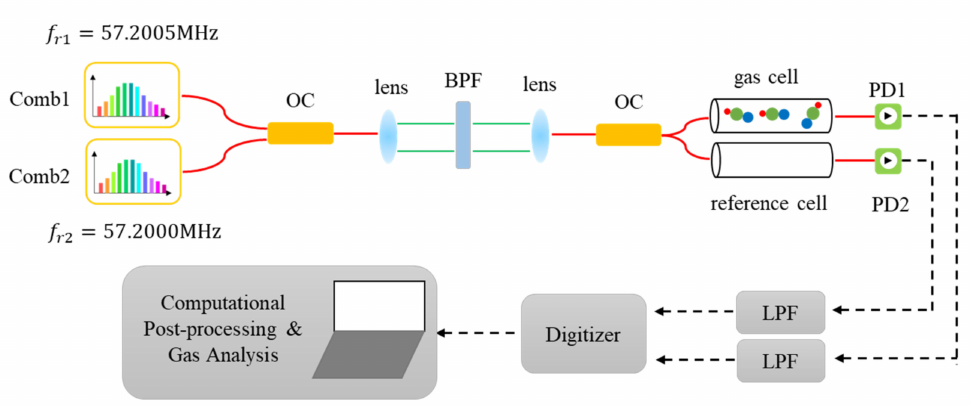
Figure 2. Experimental setup of dual-comb gas detection. Red solid lines represent single-mode fiber paths, green solid lines represent optical free-space paths, while black dashed lines represent electrical wires. OC: optical coupler; BPF: band-pass filter; PD: photodetector; LPF: low-pass filter. The repetition frequency of comb1 and comb2 are loosely locked to 57.2005 MHz and 57.2000 MHz.